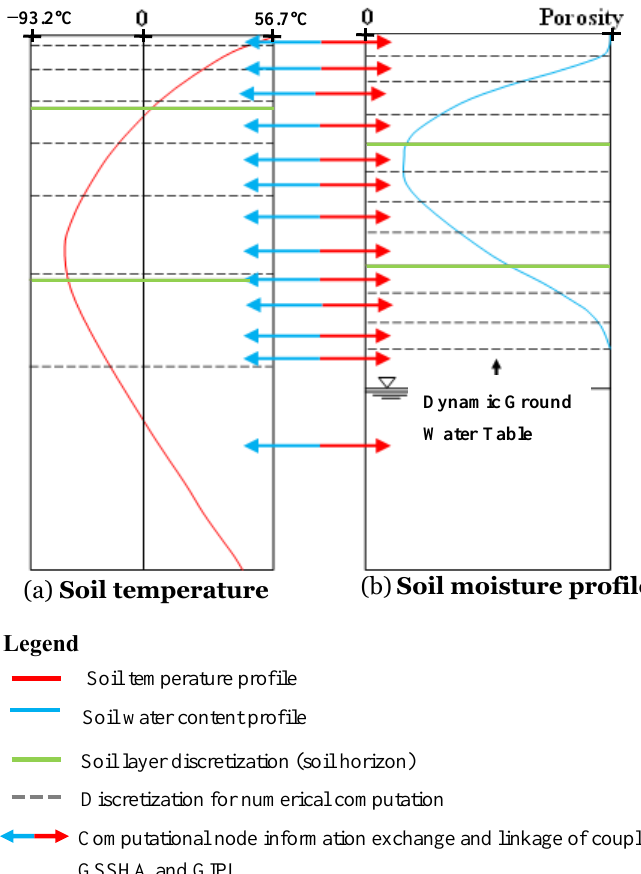
Figure 4. Thermodynamics coupling into the hydrodynamics.